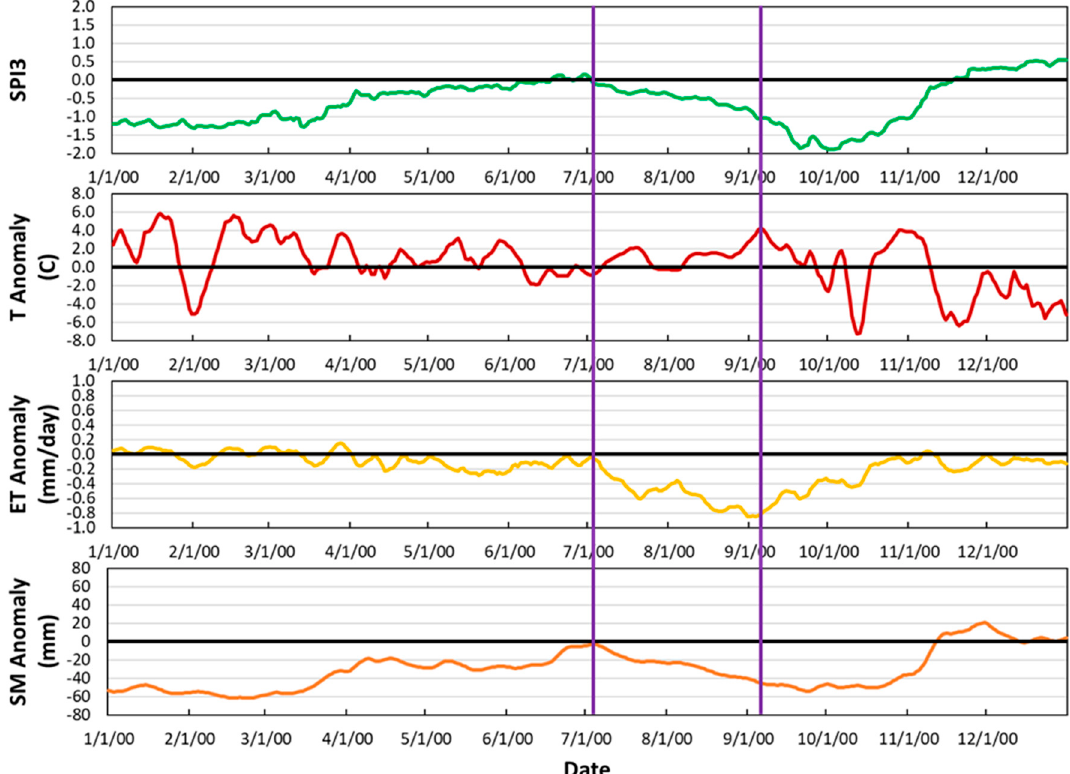
Figure 8. Time series of areal averaged three-month Standardized Precipitation Index ( first row ), seven-day mean temperature anomaly ( second row ), seven-day mean evapotranspiration anomaly ( third row ), and seven-day mean soil moisture anomaly ( fourth row ) from 1 January 2000 to 31 December 2000. The time period within the vertical purple lines is the fast-development period.